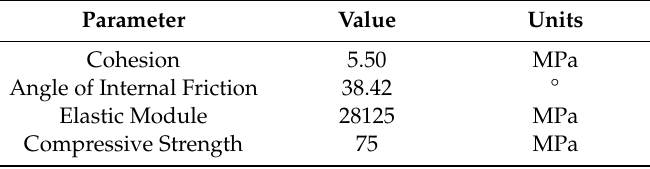
Table 5. Results of the dull inspection of drill bit according to the IADC dull grading system. BT, Table 4. Results of the geomechanical properties of